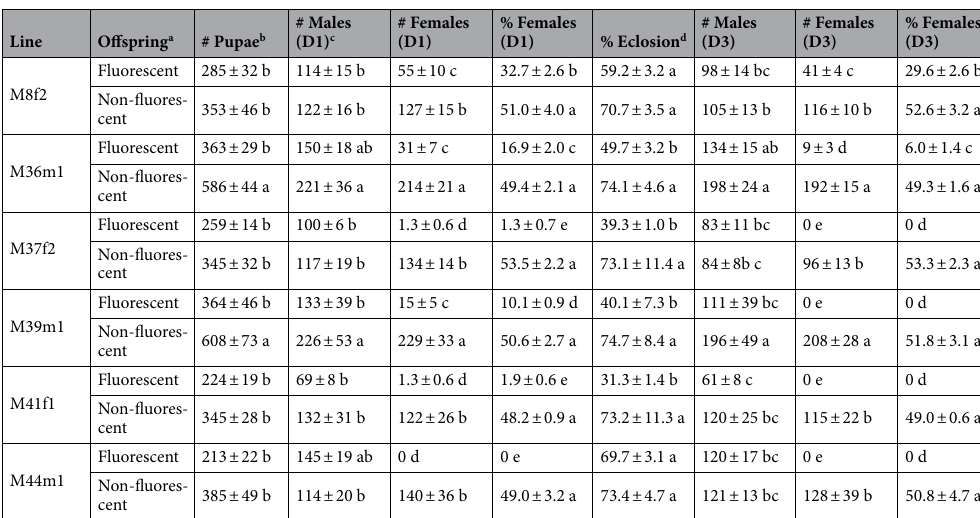
Table 2. Heterozygous tests for different V229 lines. a Five heterozygous males from each V229 line were crossed with 10 WT virgin females in the absence of tetracycline, and the number of fluorescent (transgenic) and non-fluorescent (WT) offspring were counted. b Data (mean ± standard deviation, n = 3) in the same column followed by different lower-case letter are significantly different ( P < 0.05, one-way ANOVA, Holm- Šidák method). c The adult offspring were counted either on emergence day (D1) or 3 days after emergence (D3). d The number of freshly emerged adults (D1) divided by the number of